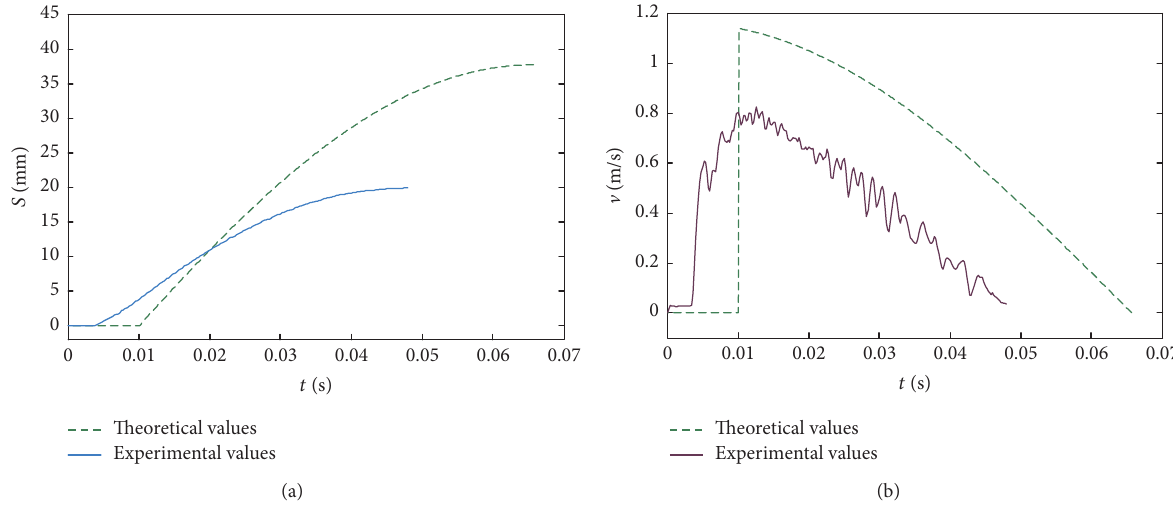
Figure 9: Comparison analysis between the theoretical and experiment base on C point. (a) The displacement curve with time. (b) The velocity curve with time. The collision conditions: 𝑀 0 = 801 g, 𝑀 1 = 355g, 𝑀 2 = 846 g, 𝑘 0 = 0.3 N/mm, and 𝑘 1 = 9.8 N/mm.